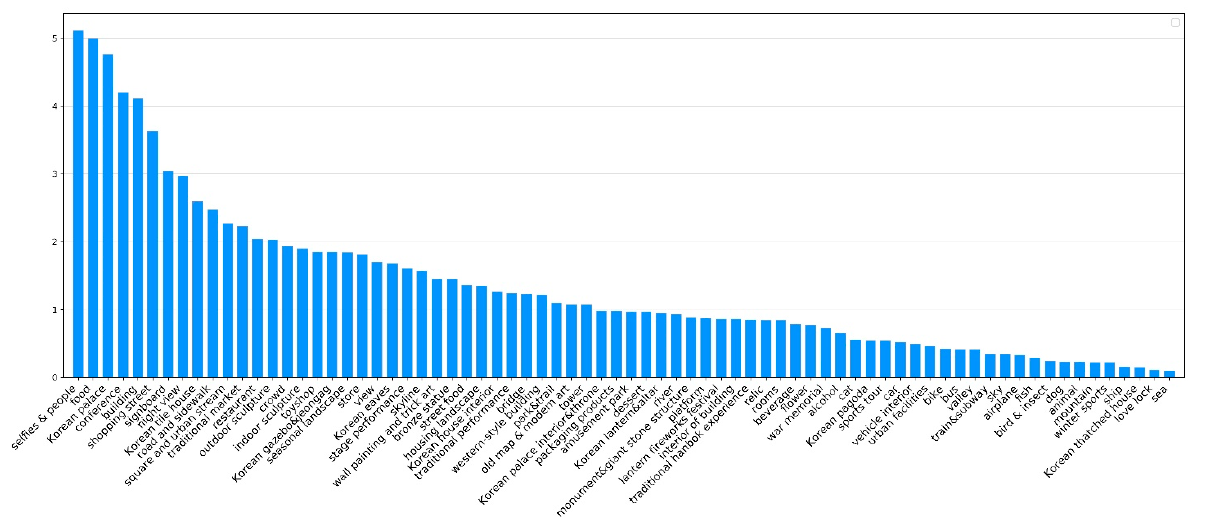
Figure 9. Major tour attractions in Seoul.